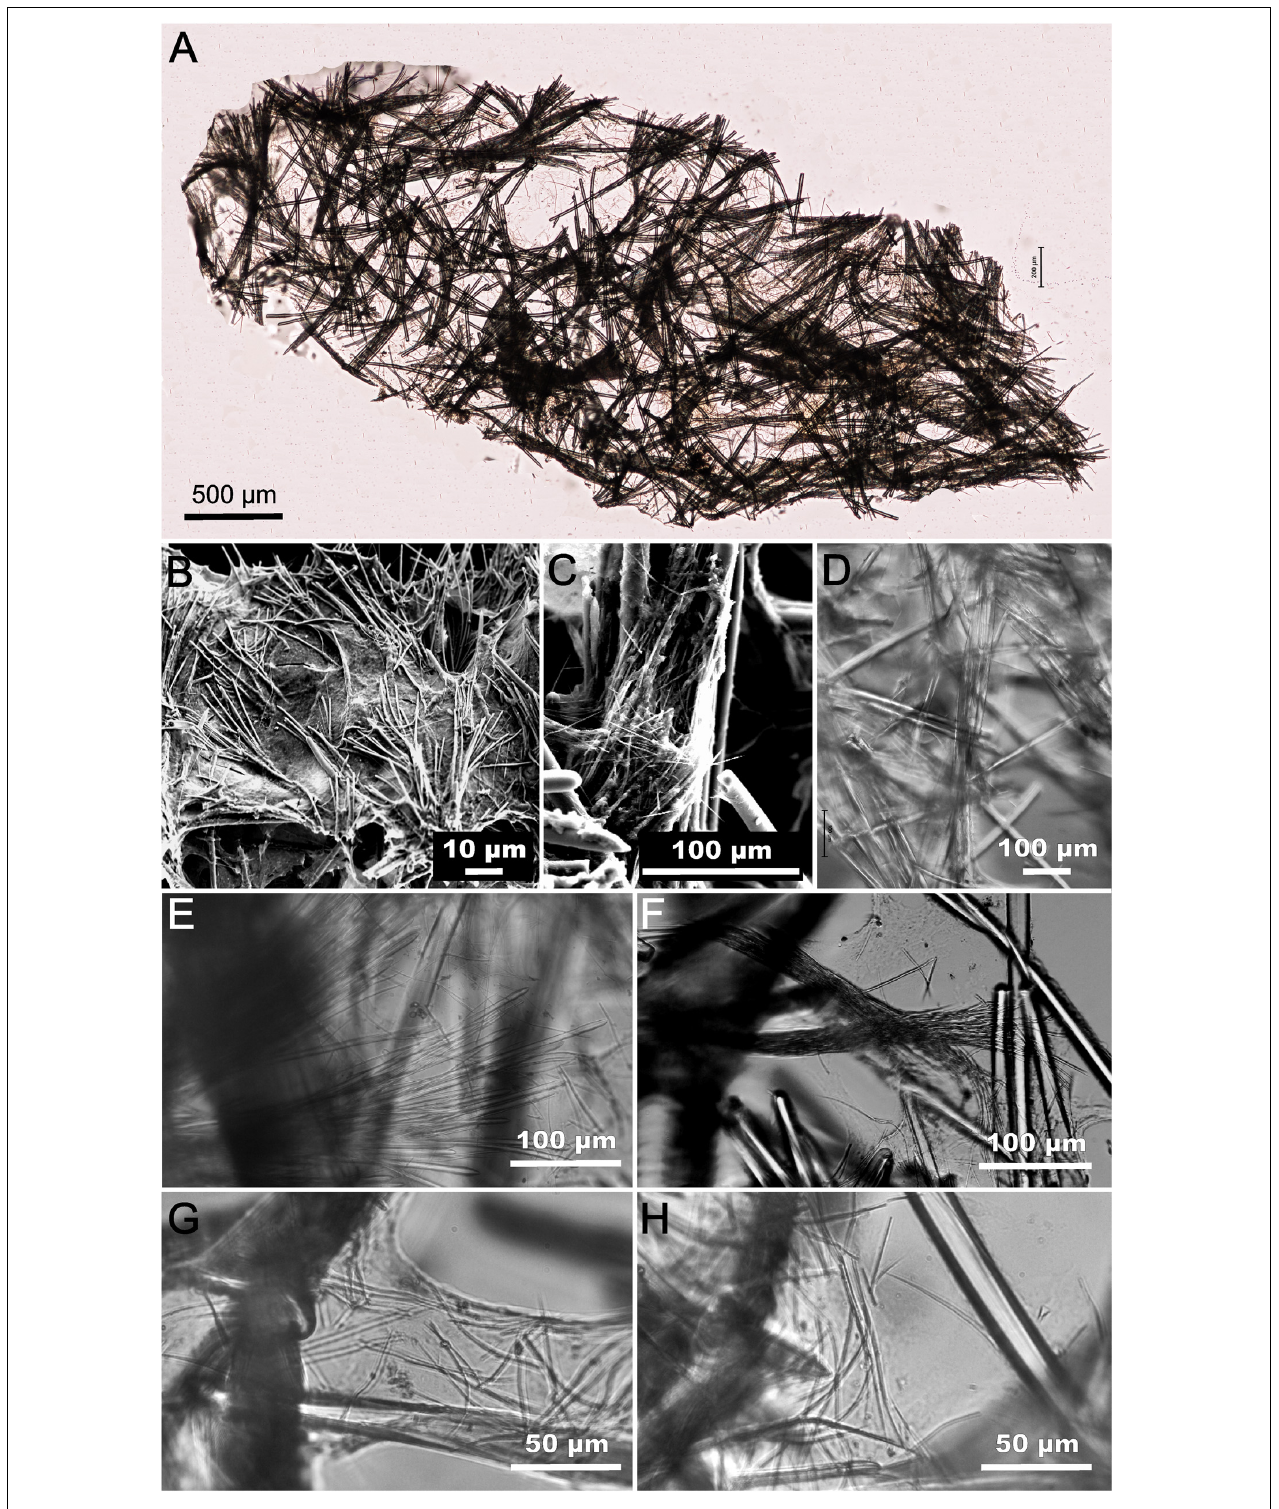
FIGURE 3 | Tedania ( Tedaniopsis ) rappi sp. nov. (A) Transversal section of a branch of holotype (light microscope, LM). (B) Scanning Electron Microscope (SEM) picture of the surface of sponge ectosomal tornotes protruding. (C) Detailed picture of group of onychaetes in choanosome (SEM). (D) Bundle of styles in choanosome (LM). (E) Bundles of tornotes projected in bouquets in the ectosome (LM). (F) Two trichodragmata in the ectosome (LM). (G) Onychaetes within a spongin fiber (LM). (H) Onychaetes in the choanosome (LM).